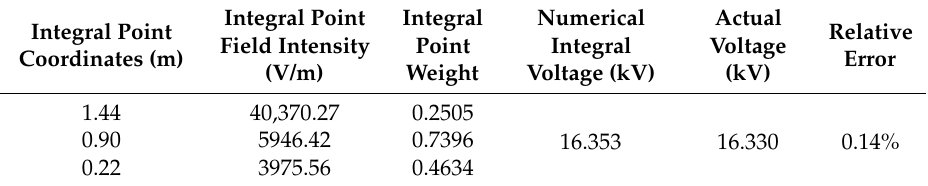
Table 3. Integration results of the Gaussian algorithm for 20 kV transmission lines.